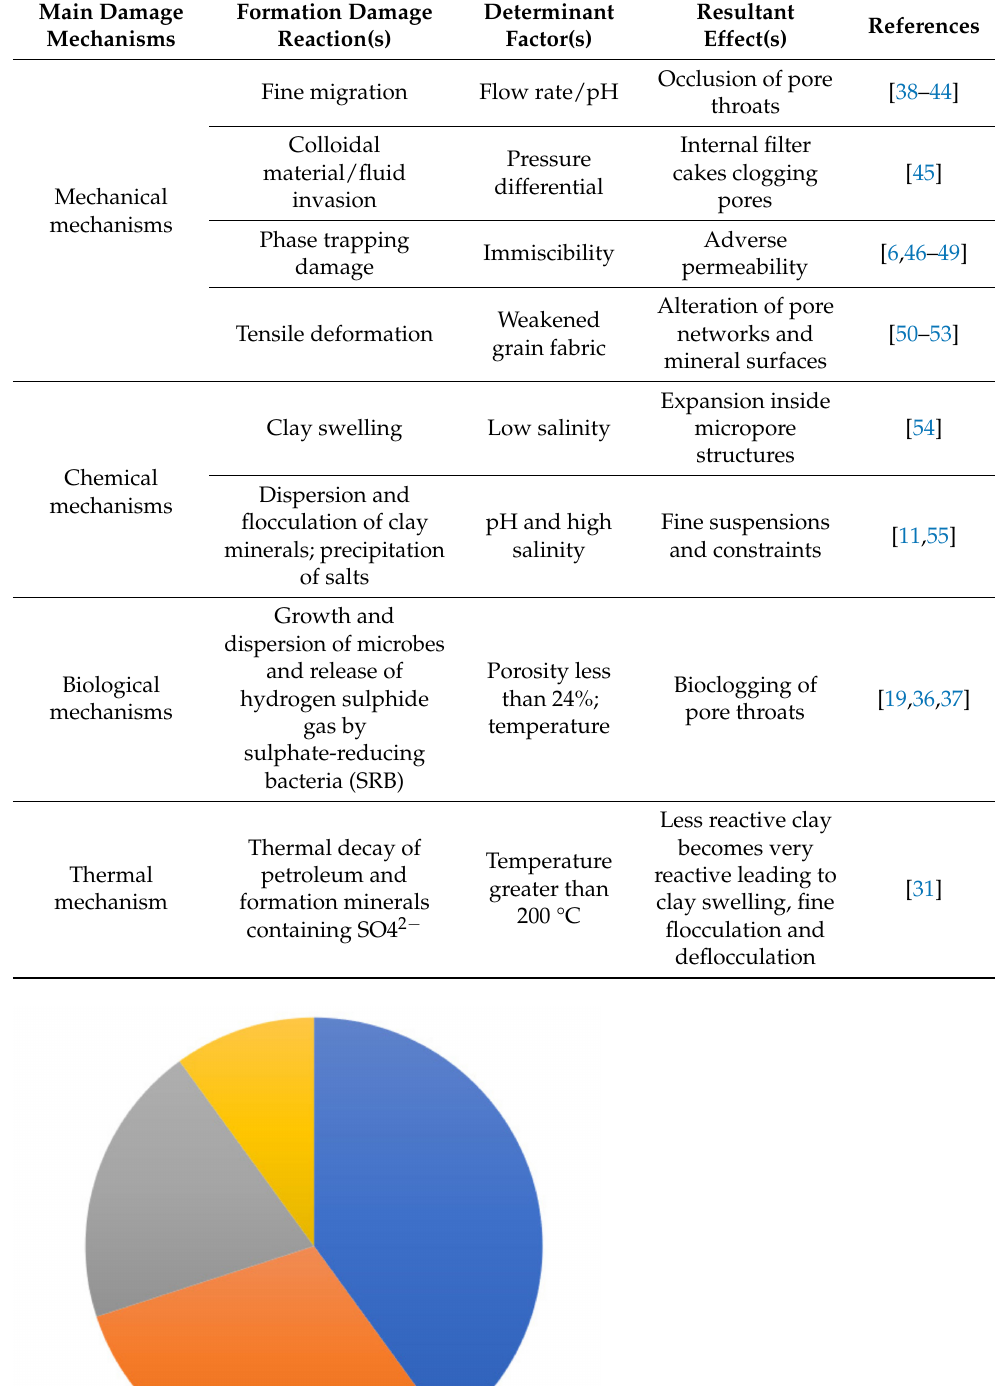
Table 1. List of common formation damage mechanisms found in sandstone reservoirs with varying clay minerals.